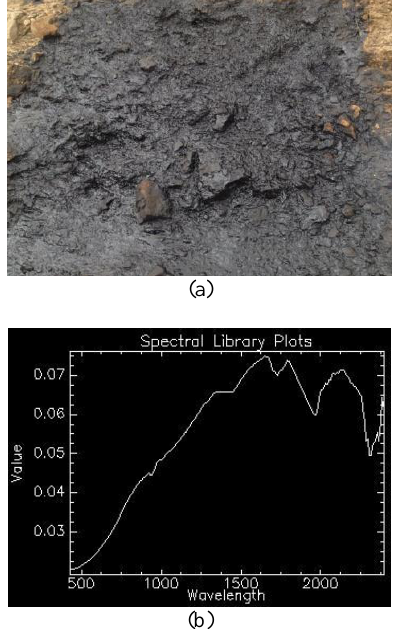
Figure 2. Hydrocarbon seeps in the area (a) and its spectrum recorded (b)